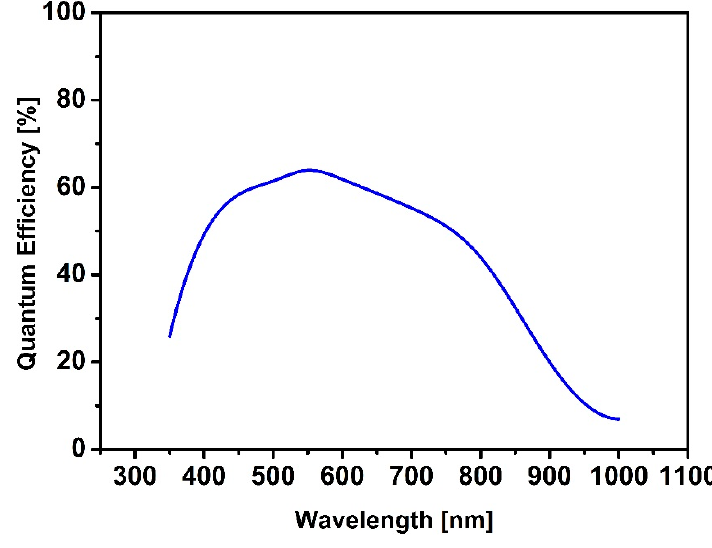
Figure 3. Quantum Efficiency curve of the detector. Figure 3. Quantum E ffi ciency curve of the detector.